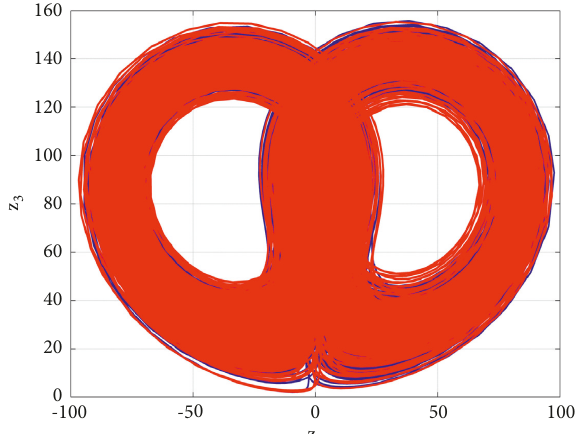
Figure 27: The coexistence of chaotic attractors for system (1) , z ) coordinate plane for the choice of pa- projected in the ( z 2 3 rameters ( a,b, c,d ) � ( 25 , 14 , 90 , 6 )